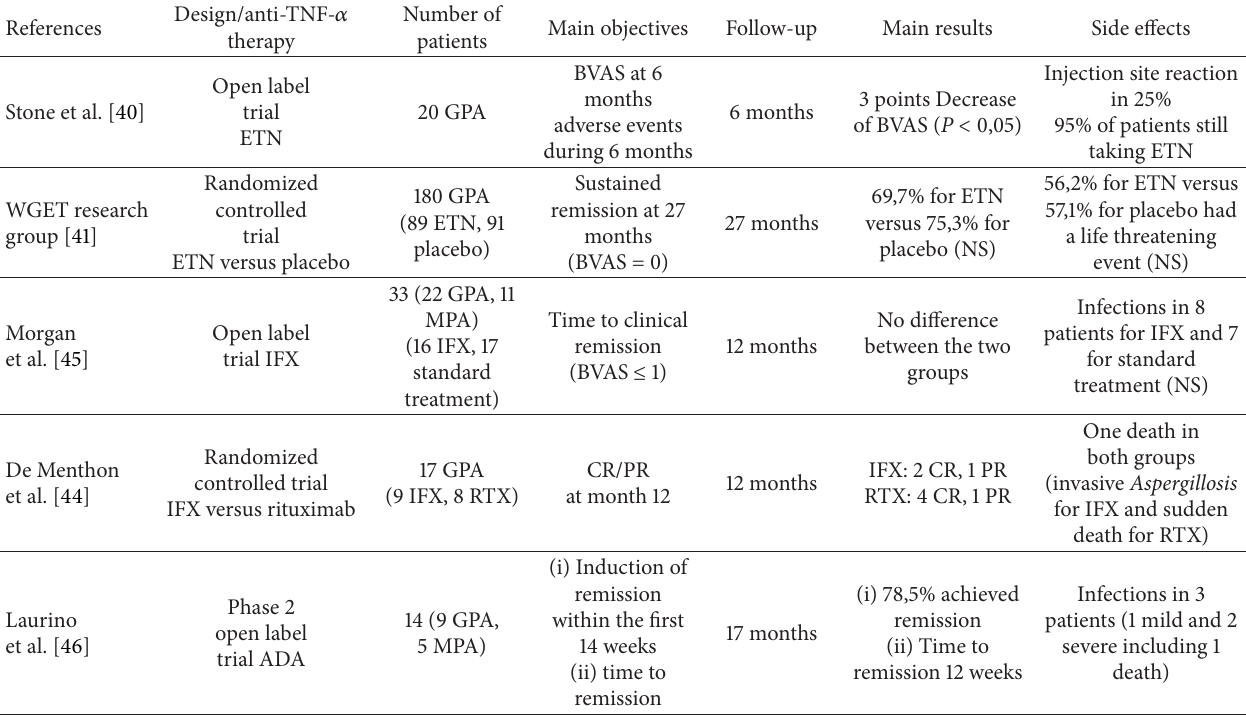
Table 3: Open label and randomized controlled trials performed in